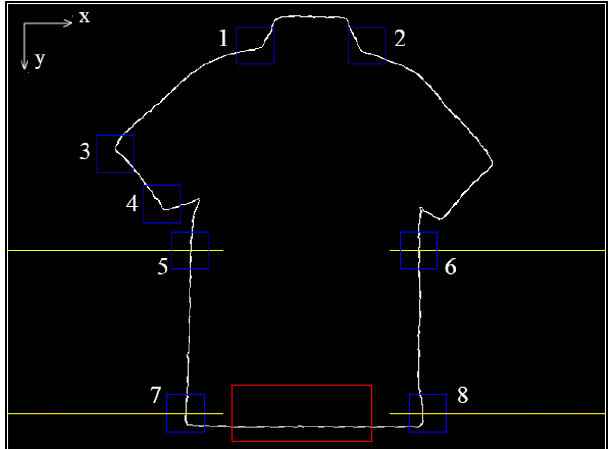
Figure 12. Defined recognition regions.